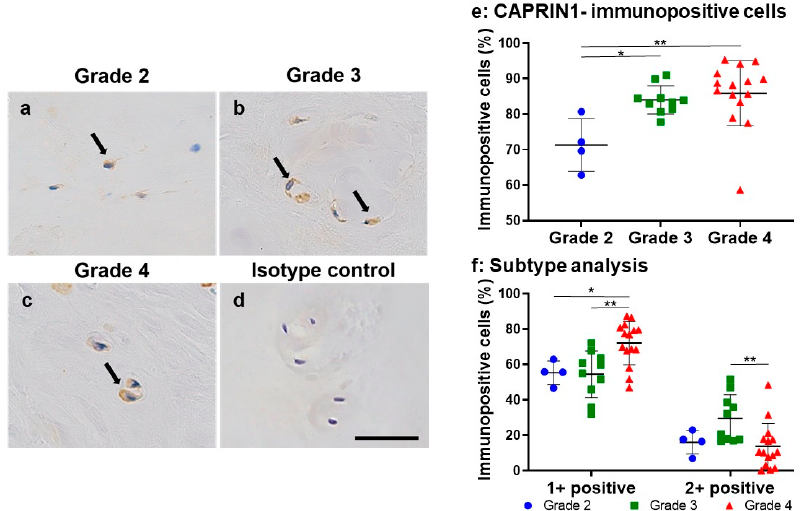
Figure 8. Immunohistochemical staining for CAPRIN1 ( a – c ) in human nucleus pulposus (NP) tissues. Pfirrmann grade 2 ( a ), grade 3 ( b ), and grade 4 ( c ), and isotype control ( d ). Scale bar: 50 μ m (×400 magnification). Percentage of immunopositive cells for CAPRIN1 ( e ) and the subtype analysis by the intensity of immunostaining ( f ) in human nucleus pulposus (NP) tissues by Pfirrmann classification. * p < 0.05, ** p < 0.01.